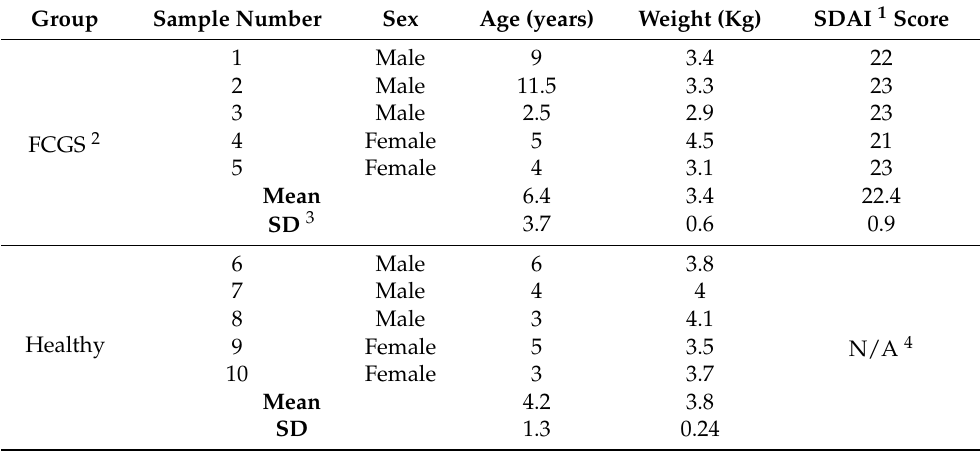
Table 1. Information about the animals selected for the FCGS and the control group. The sex, age, weight and SDAI score are presented. None of the selected cats were spayed or neutered.